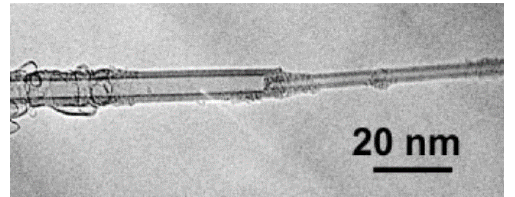
Figure 13. TEM image of a telescoped nanotube. Adapted with permission from [57], Copyright AAAS,